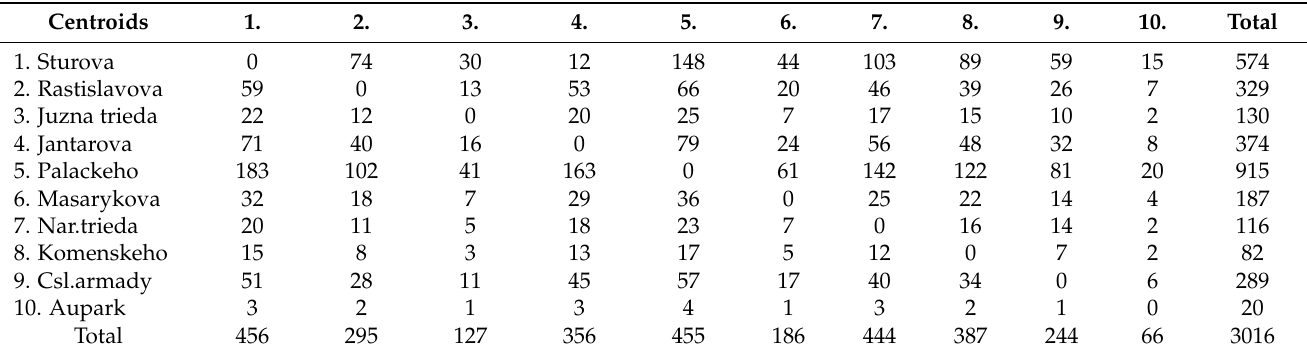
Table 9. Historical matrix for Variant B, (source elaborated by